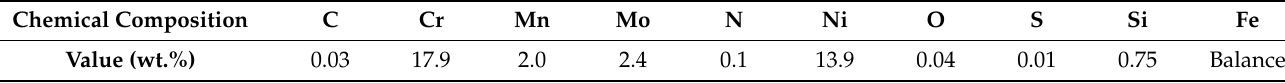
Table 1. Chemical composition of 316L stainless steel powder used as the feedstock material for the AM process (wt.%). Chemical Composition C Cr Mn Mo N Ni O S Si Fe Value (wt.%) 0.03 17.9 2.0 2.4 0.1 13.9 0.04 0.01 0.75